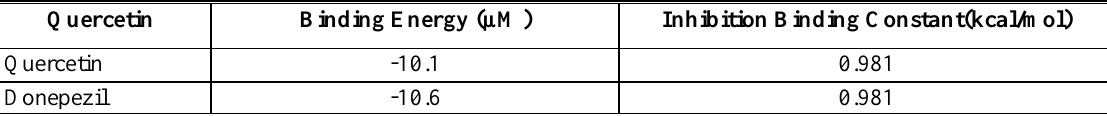
Table 3. Binding Energy and inhibition binding Constant of Quercetin against Acetylcholinesterase Receptor bound to Donepezil